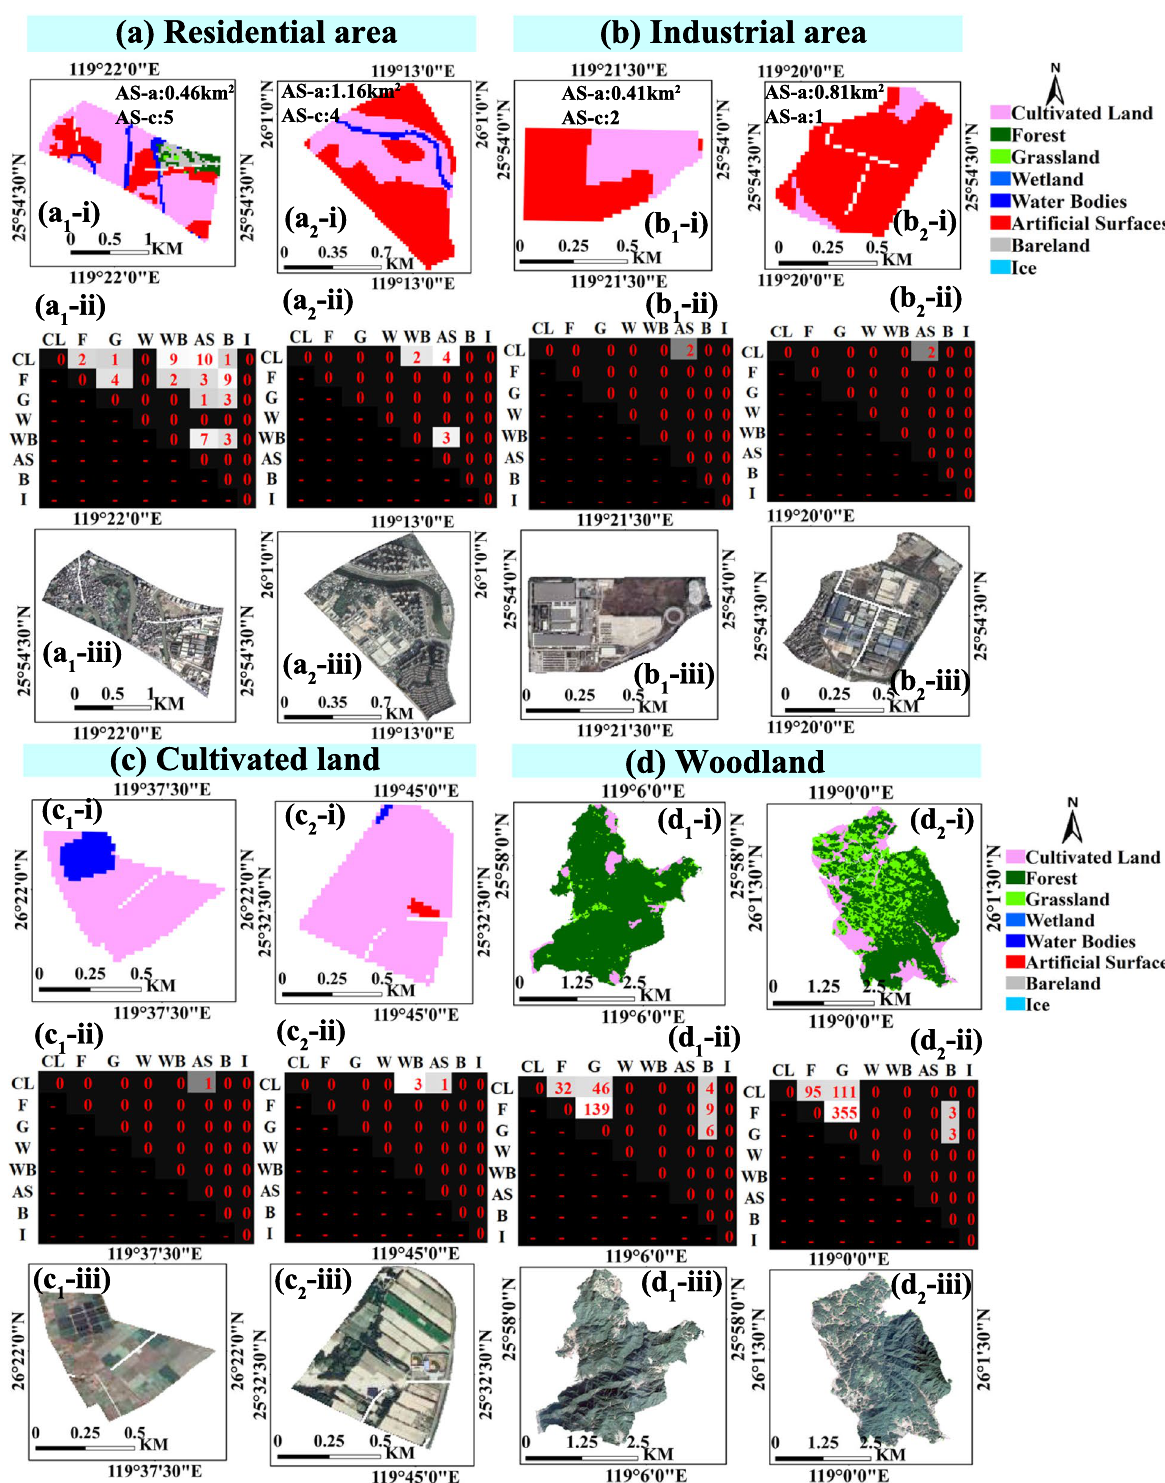
Fig. 4 (i) Land cover maps, (ii) LCSC matrix and (iii) remote sensing imageries of ( a ) residential area, ( b ) industrial area, ( c ) cultivated land and ( d )